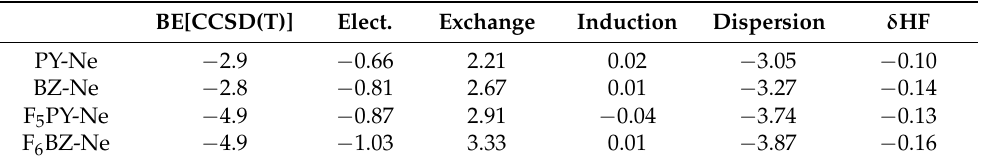
Table 5. Bonding energies (BE in kJmol − 1 ) calculated at the CCSD(T) level and DFT-SAPT contribu- tions for the complexes PY-Ne, BZ-Ne, F 5 PY-Ne, and F 6 BZ-Ne. BE[CCSD(T)]